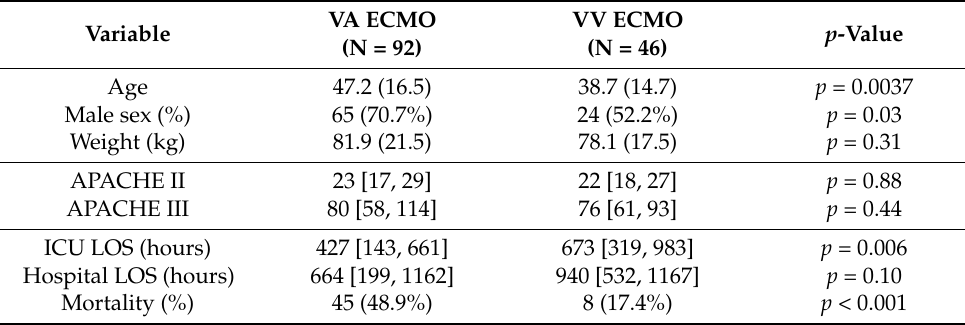
Table 1. Patient demographics by ECMO